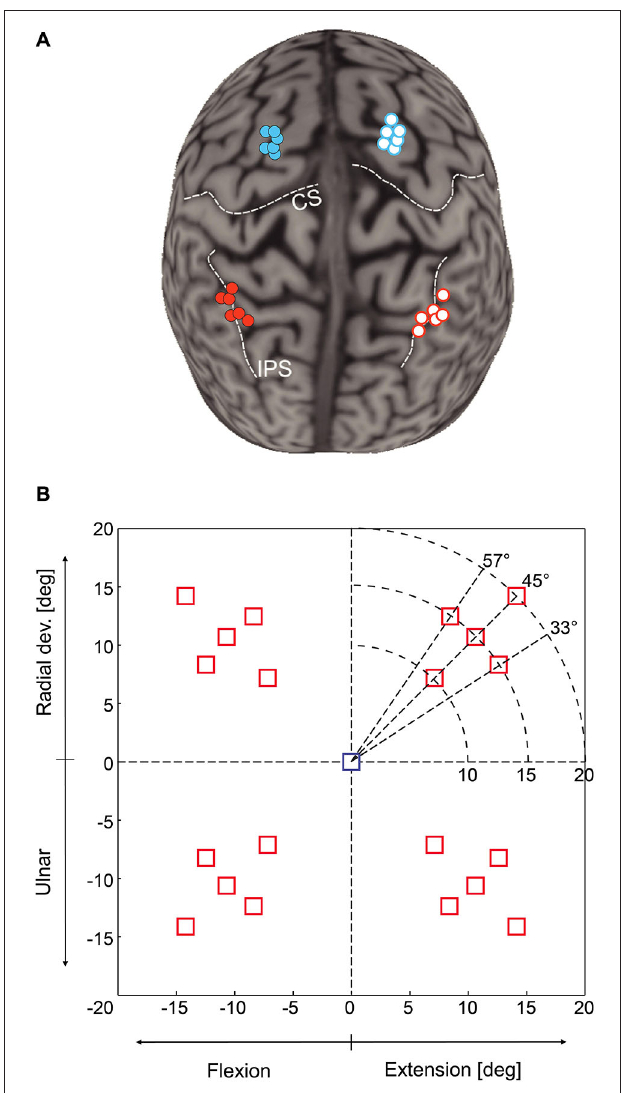
FIGURE 1 | (A) Location of transcranial magnetic stimulation (TMS) sites over mIPS and PMd in the left and right hemispheres after normalization into the MNI coordinate system ( n = 6 for each site). The template used for rendering the cortical surface is Colin27 and each normalized stimulation point has been projected on the template cortical surface using the Brainsight stick tool (Rogue research, Montreal). (B) Location of the 20 possible target locations on the computer screen; only one target was randomly displayed during a given trial. The central square represents the starting point. The horizontal axis is the flexion-extension axis of the wrist, the vertical one the radial-ulnar deviation axis. In each quadrant, there were 5 possible target locations: 3 directions (45 ± 12 ◦ ) and for the target along the 45 ◦ axis, 3 possible eccentricities (10, 15 or 20 ◦ ). Targets were either displayed for the whole movement duration (Target-ON condition) or flashed only for 200 ms (Target-OFF condition).